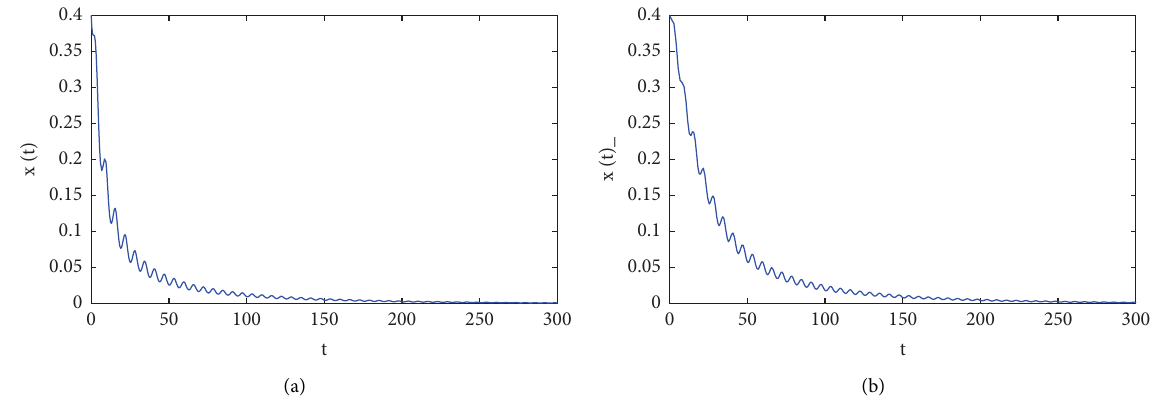
Figure 2: Te lines represent the solution of model (8) for r ( t ) � − 0 . 01 + 0 . 2sin t, K � 1, initial data x C � 2 , a ( t ) � 0 . 5 , σ ( t ) � c ( u ) � 0; (b) C � 6 ,a ( t ) � 0 . 5 , σ ( t ) � c ( u ) �